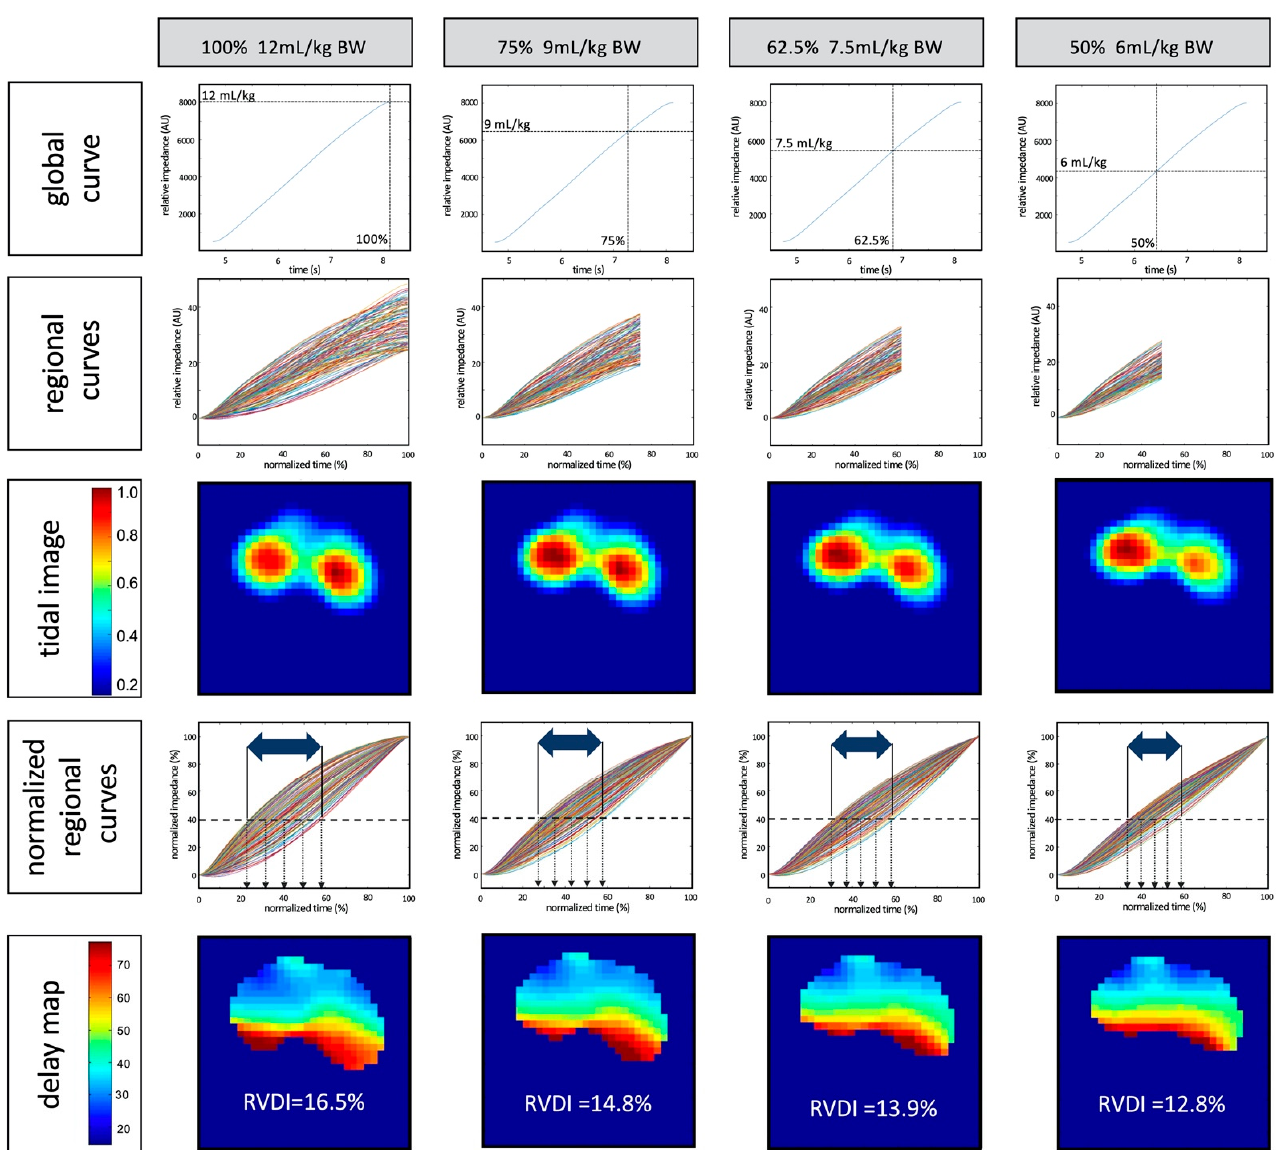
Figure 1. Calculation of regional ventilation delay inhomogeneity (RVDI) to quantify the time disparities between regional ventilation curves that are correlated with tidal recruitment [16]. Left column: calculation from the original 12 mL/kg of body weight (BW; 100%) slow inflation; other columns (left to right): calculation from the simulated reduced inflation volume of 9, 7.5, and 6 mL/kg BW at 75%, 62.5%, and 50% inflation times, respectively. Rows (top to bottom): global impedance/time curves; regional impedance/time curves; resulting electrical impedance tomography (EIT) images of tidal ventilation; normalized regional impedance/time curves, in which downward arrows indicate regional ventilation delay (RVD) indices (delay times at which regional curves reach the regional 40% inflation threshold and horizontal two-sided arrows symbolize time disparity); and delay maps with resulting RVDI values. Methodological schematic description, adapted from Muders et al. [18].